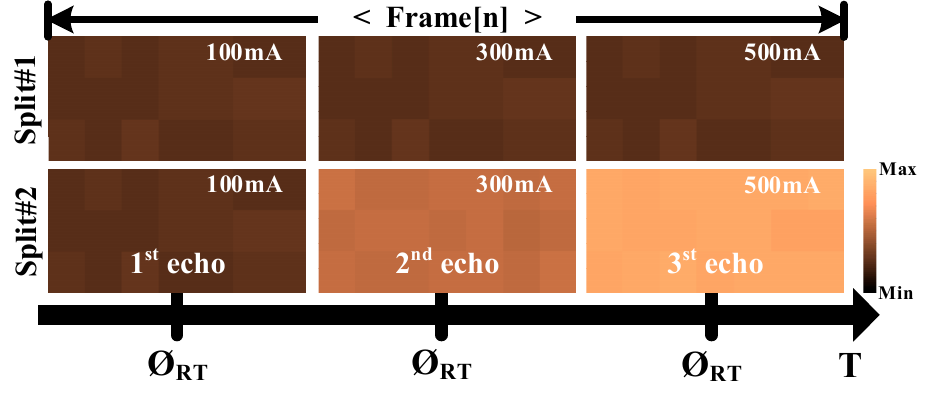
Figure 14. The multiple echo detection capability of the Split#1 and Split#2.